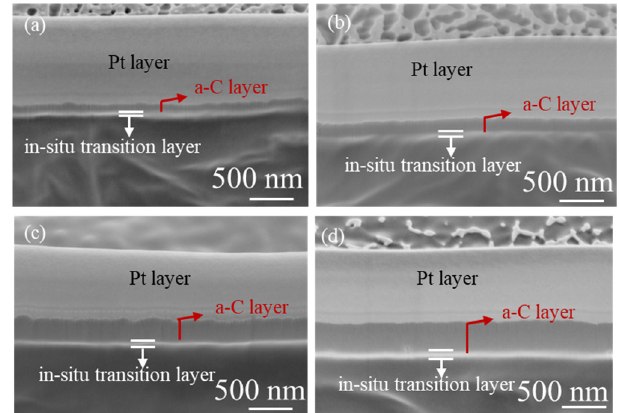
Figure 5. Cross-section morphologies of UHMWPE substrates treated with different carbon plasma currents: ( a ) 0.5 A, ( b ) 1.0 A, ( c ) 1.5 A, ( d ) 2.0 A.